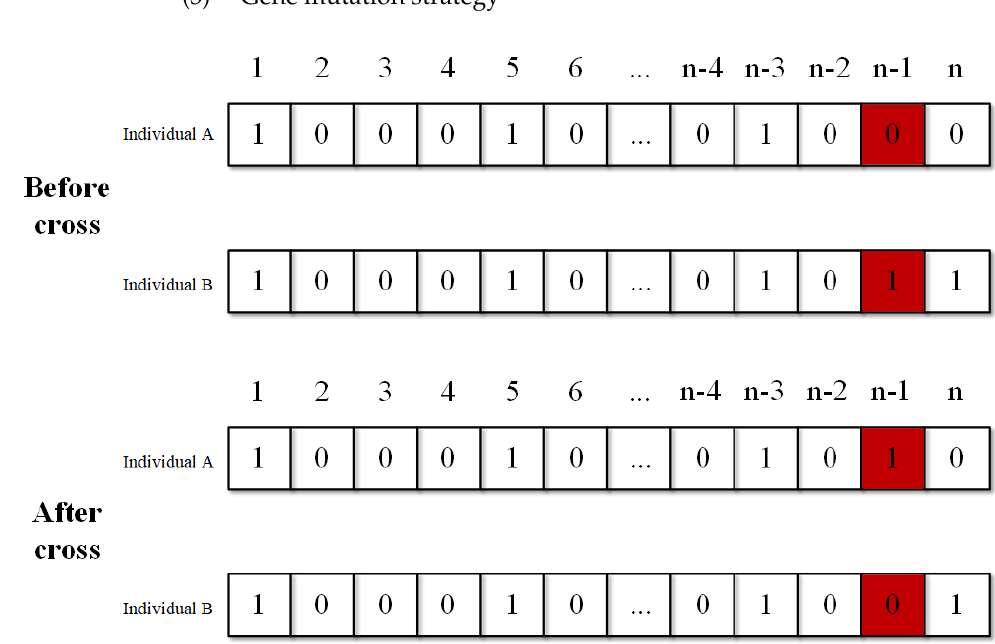
Figure 5. Gene crossover diagram.